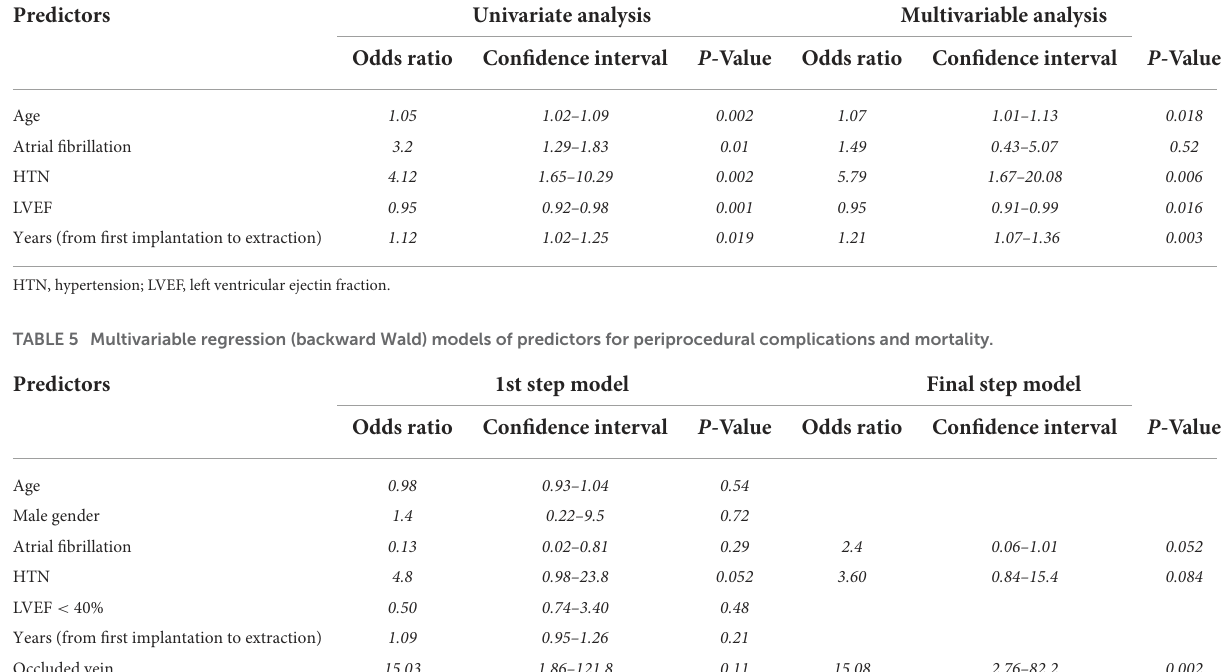
TABLE 4 Multivariate analysis of predictors for occluded veins.